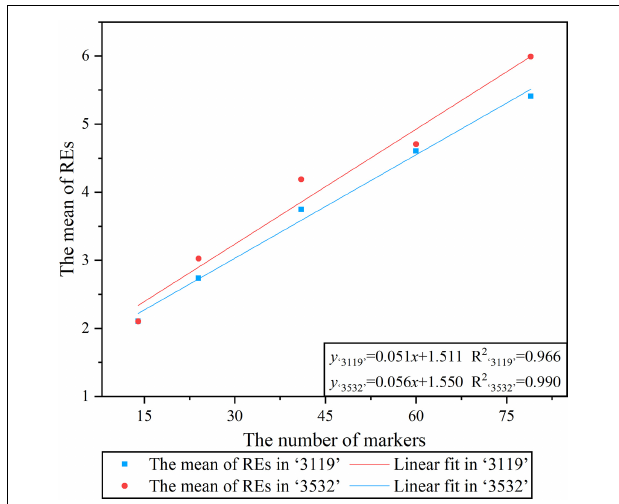
FIGURE 3 | Linear regression analysis between the number of markers and the average recombination events.